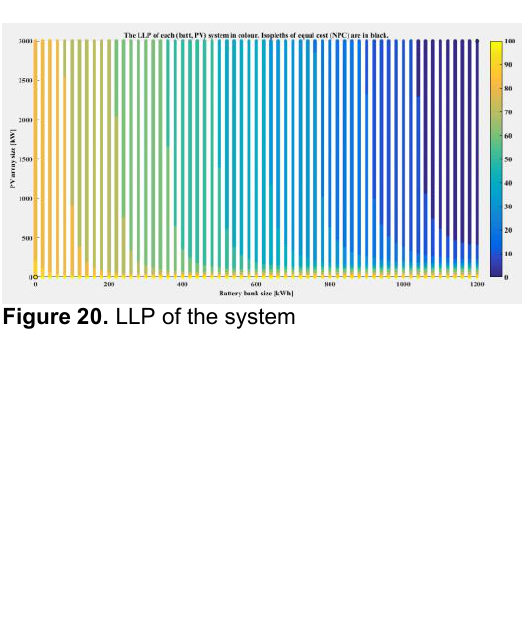
Figure 23. Isodepth of Equal Costs 600 to 1600